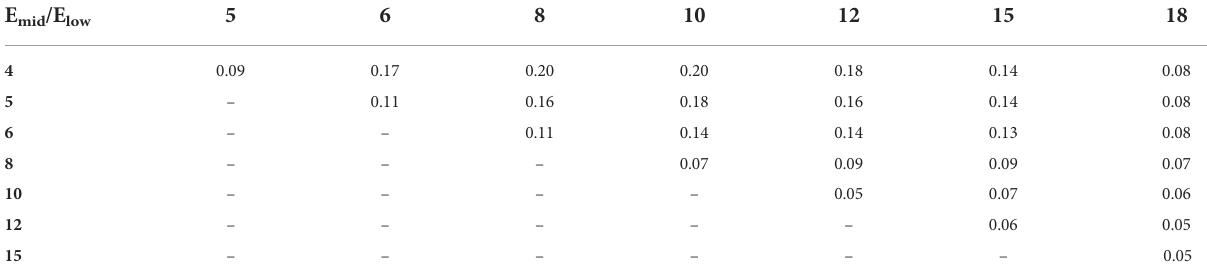
TABLE 4 RMSE (%) of different synthetic energy for the 100 × 100 mm 2 fi eld with 21 MV as E high . E mid /E low